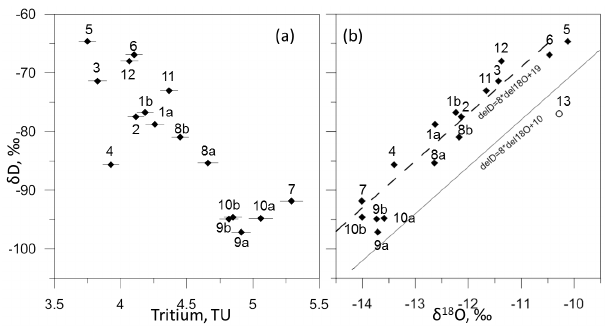
Figure 6. Relationships between δ D and tritium (a) , and δ D and δ 18 O (b) in Hokkaido river waters (diamonds) and rain (open cir- cle). Labels refer to IDs in Table